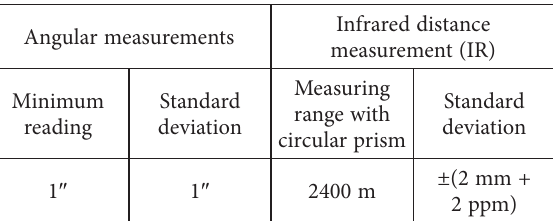
Table 2. Topcon GTS710 total station specifications